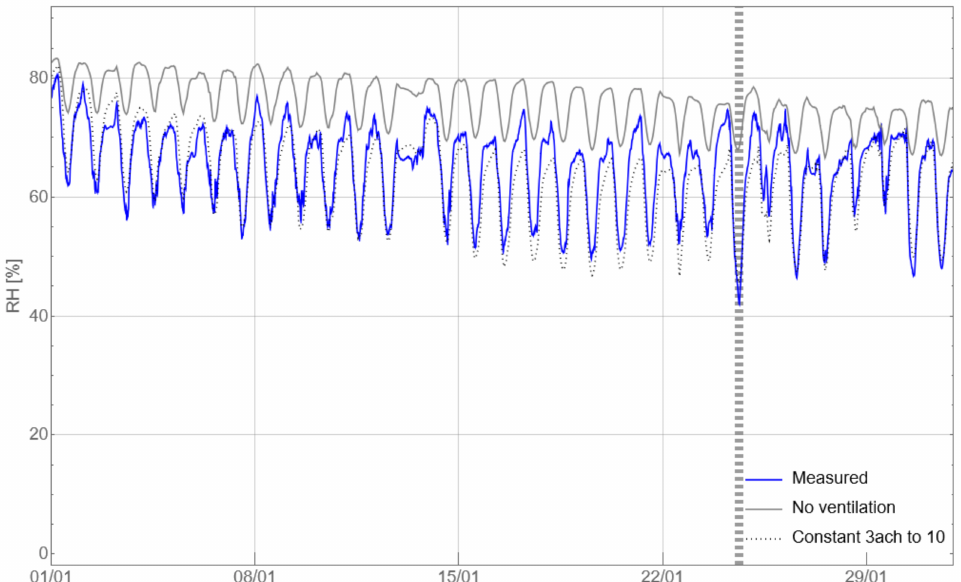
Figure 10. Results from the WUFI ® 2D simulation—relative humidity of the roof cavity air simulated for no ventilation and ventilation boosting from 3 ach to 10 ach (daytime, 3 ach otherwise) after the fan is